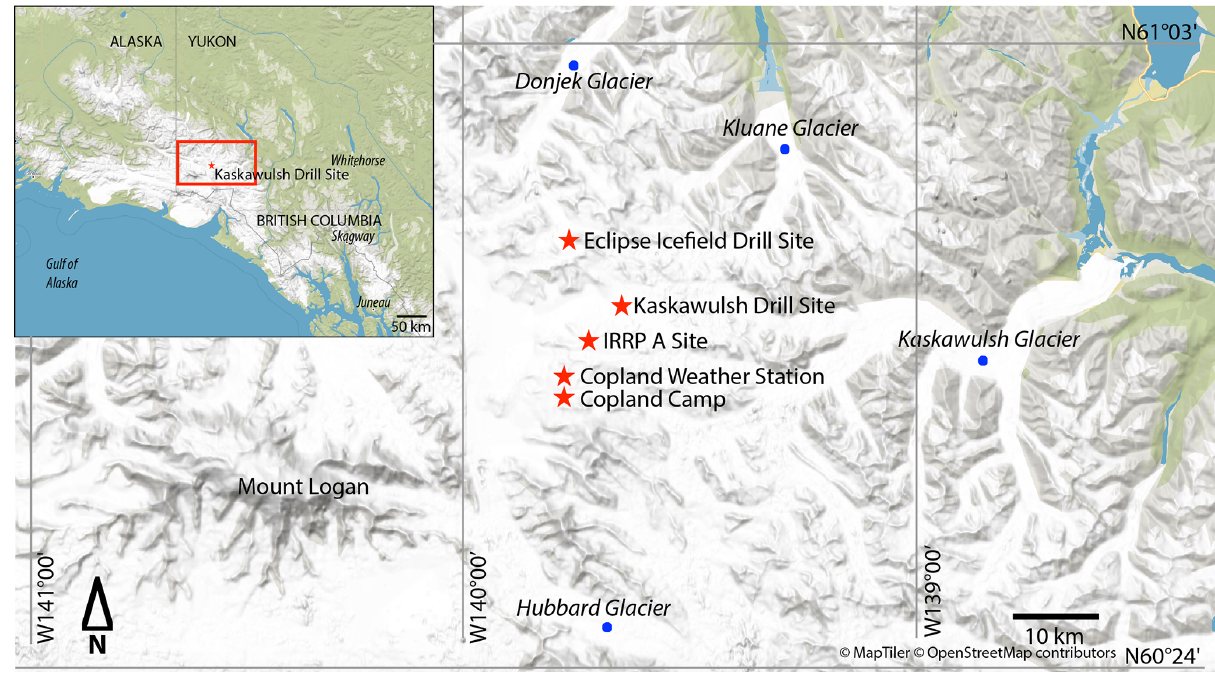
Figure 1. Field locations in the St. Elias ice field, Yukon. The IRRP A site is the site of the 1964 firn core that is referenced in our study (Grew and Mellor, 1966). Base map from http://openmaptiles.org/ (last access: 17 March